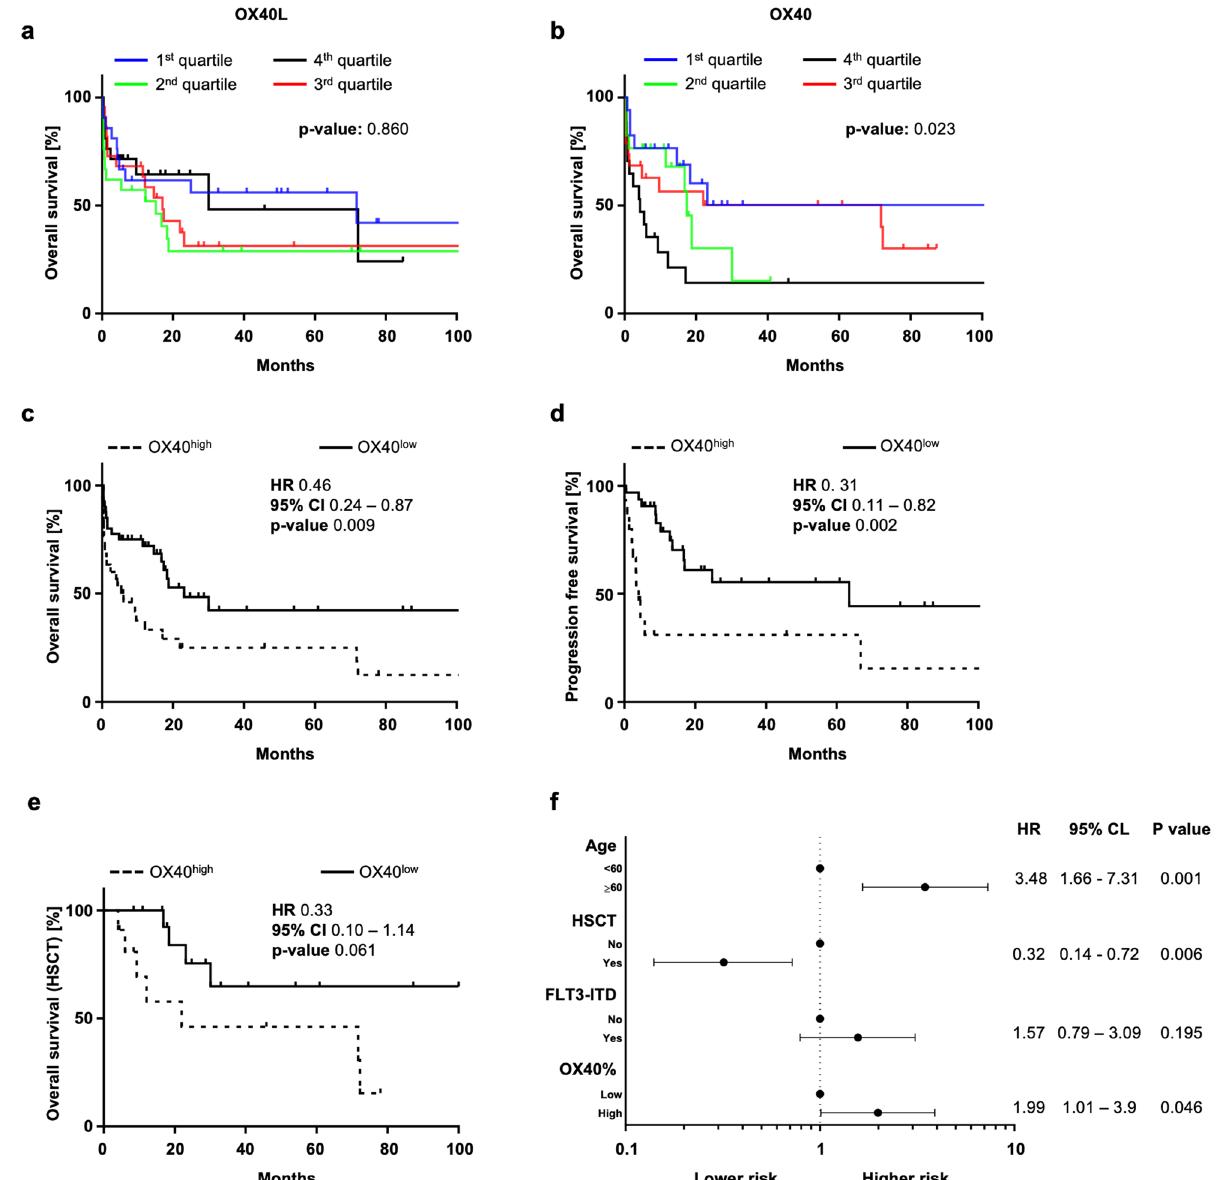
Figure 3. Impact of OX40 and OX40L expression on clinical outcome. The Overall Survival (OS) in AML patients is shown according to OX40L ( a ) and OX40 ( b ) expression (4 quartiles identified between minimal and maximal expression) in Kaplan–Meier analysis. OS in patients with OX40 high and OX40 low expression is shown (Kaplan–Meier analysis) ( c ). Median OS was reached in OX40 high (dotted line) and OX40 low (continuous line) patients after 6 and 23.2 months, respectively, and differed significantly (log-rank test). Progression-free survival (PFS) is shown according to OX40 expression in Kaplan–Meier analysis ( d ). PFS of OX40 high (dotted line) and OX40 low (continuous line) patients was 4.2 and 63.5 months, respectively, and differed significantly (log-rank test). OS of OX40 high (dotted line) and OX40 low (continuous line) transplanted patients is shown (Kaplan–Meier analysis) ( e ). Median OS was reached for OX40 high patients after 21.97 months. A multivariate survival analysis (cox regression) including the expression of OX40 (high. vs low), patients’ age (< 60 vs. > = 60 years), FLT3- ITD and the ASCT status of 65 AML patients was performed ( f ). HR = Hazard ratio, 95% CI = 95% confidence